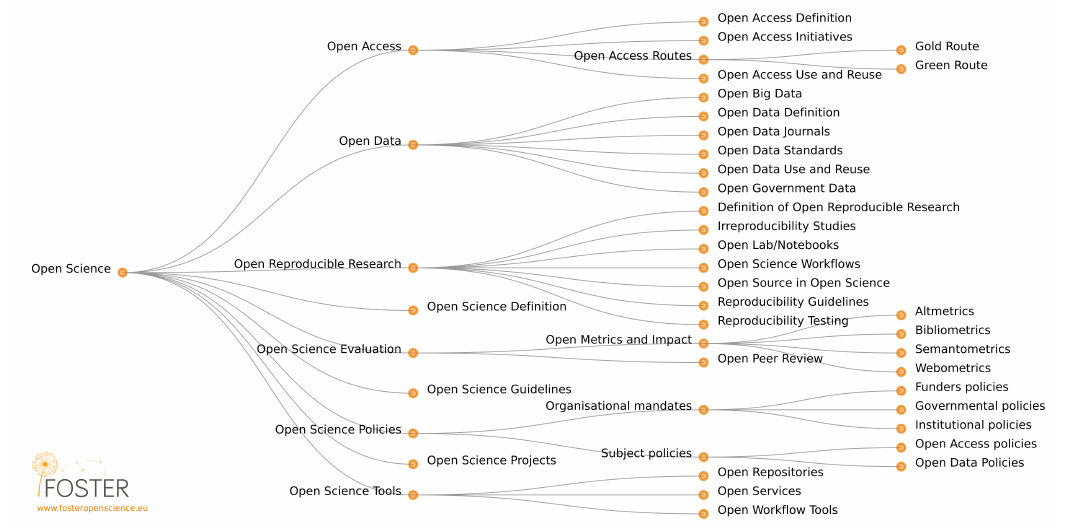
Figure 1. Open Science Taxonomy.